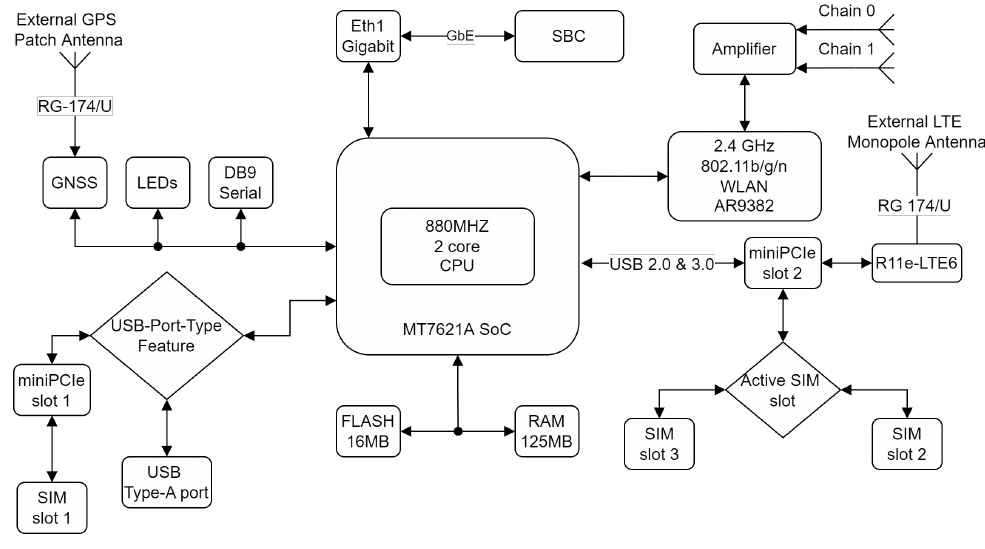
Figure 1. Collection system block diagram [33].